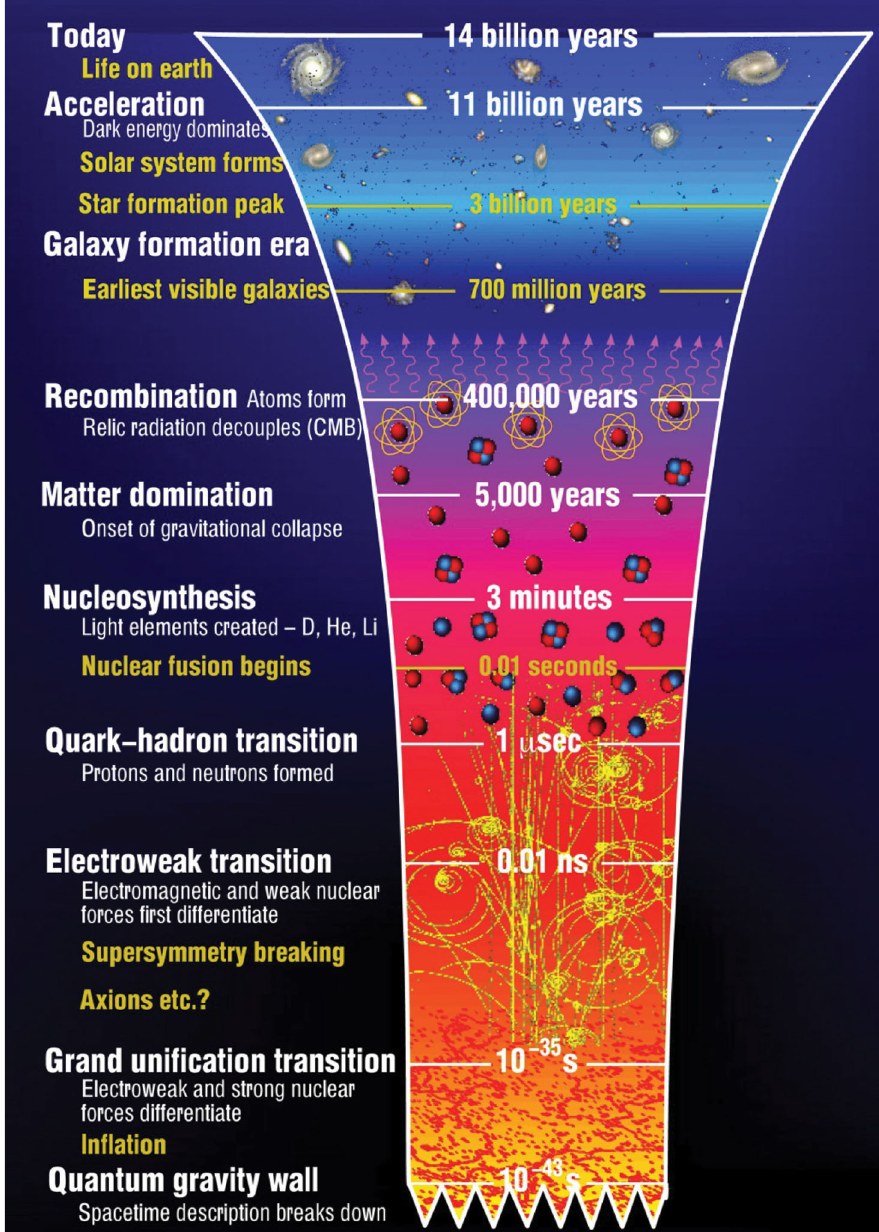
FIG. 17. Timeline of the Universe, another variation of the representations of this concept. Image credit: Center for Theoretical